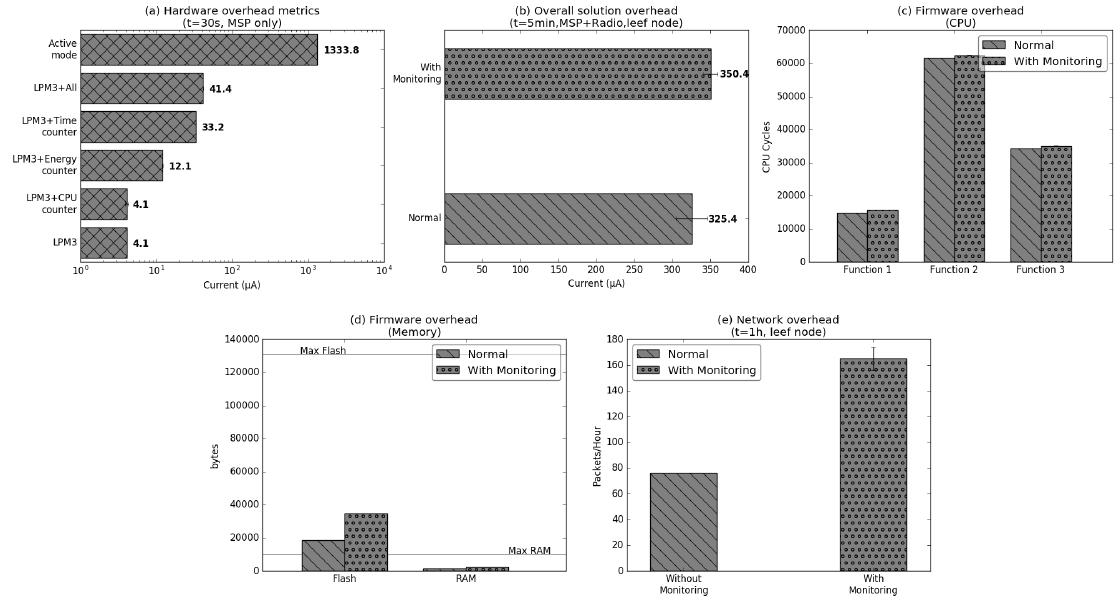
Figure 4. Obtained